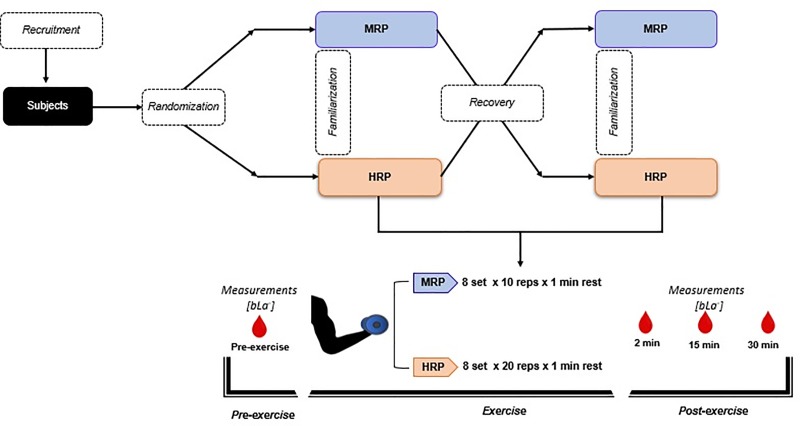
Experimental design.